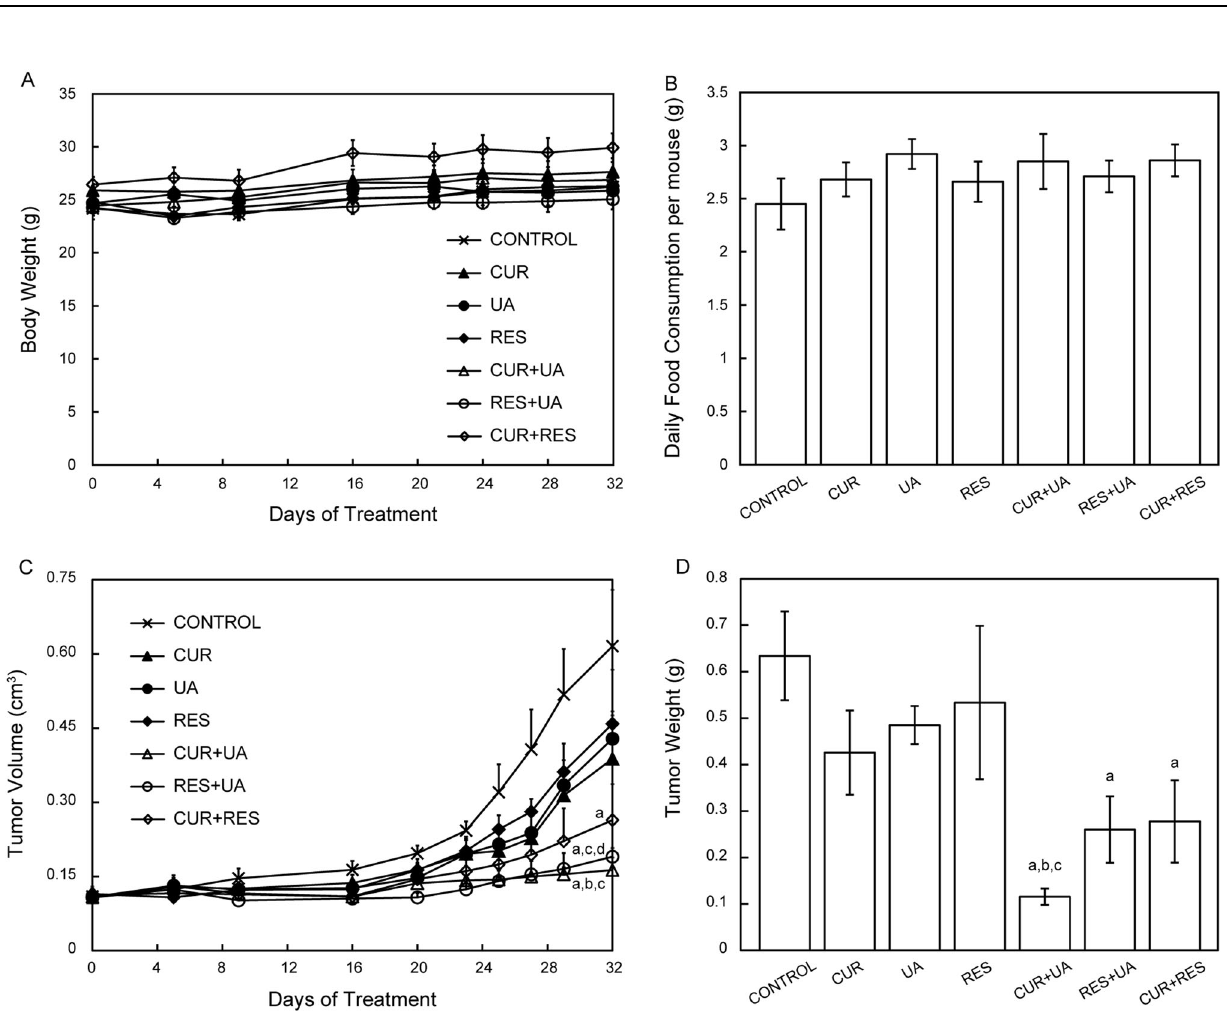
Fig. 2 In vivo effect on HMVP2 tumor growth of treatment with CUR, UA, RES and their combinations. HMVP2 cell spheroids were injected subcutaneously into the fl ank of male FVB/N mice. Mice were fed ad libitum with semipuri fi ed AIN76A-based diet containing CUR, UA, RES or their combinations of two natural compounds. Body weight ( a ), food consumption ( b ), tumor volume ( c ) and tumor weight ( d ) are shown as mean ± SEM. One-way ANOVA with signi fi cance at p < 0.05 was used. Statistical signi fi cance is shown as different from control ( a ), CUR ( b ), UA ( c ) and RES ( d